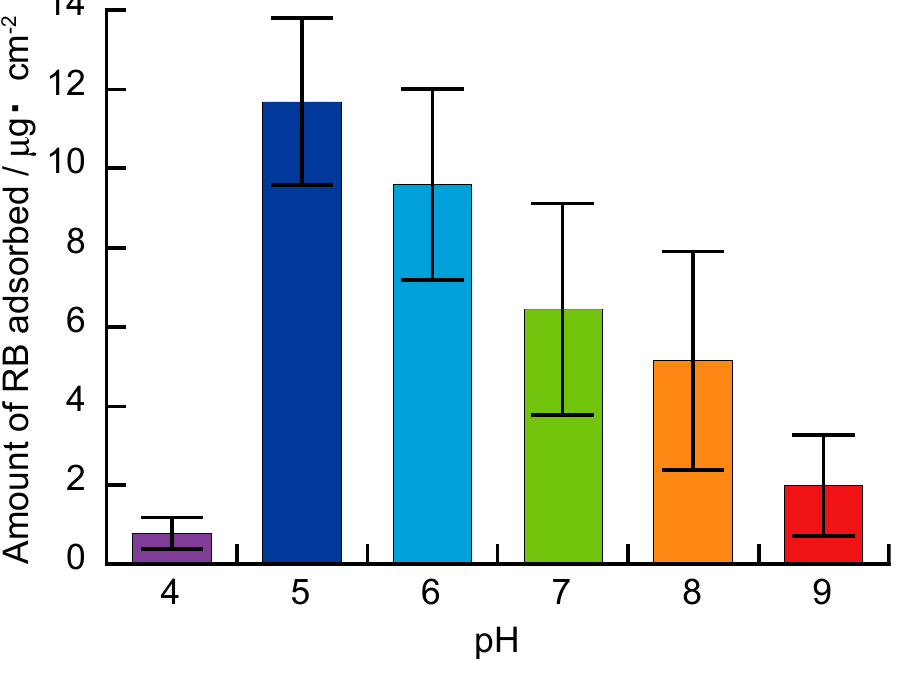
Figure 9. Amount of RB-absorbed on (PBA-PAMAM/PVA) 5 films after immersion in RB solution with different pHs.